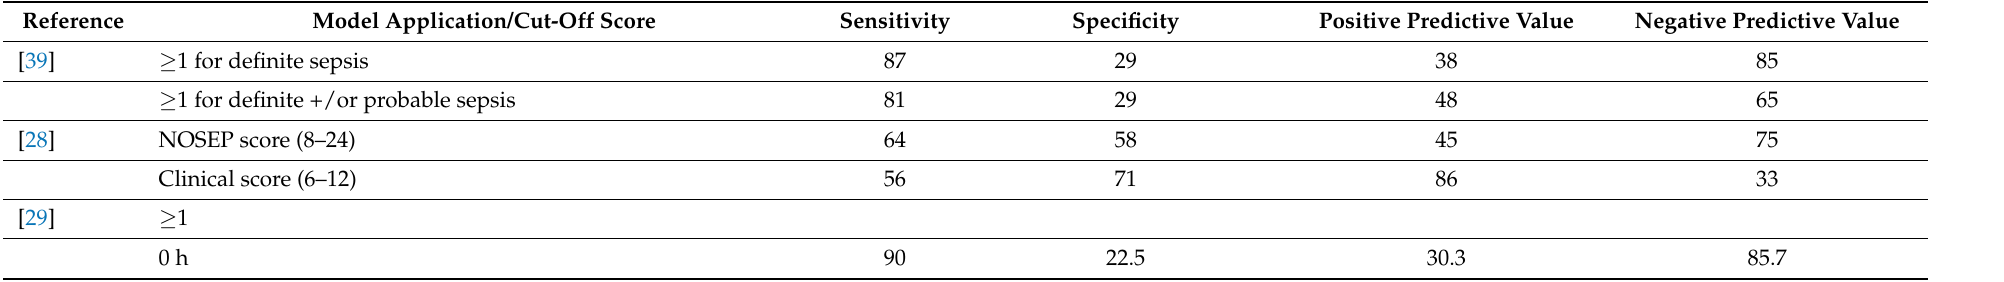
Table 4. Diagnostic power of the predictive scores as calculated in each